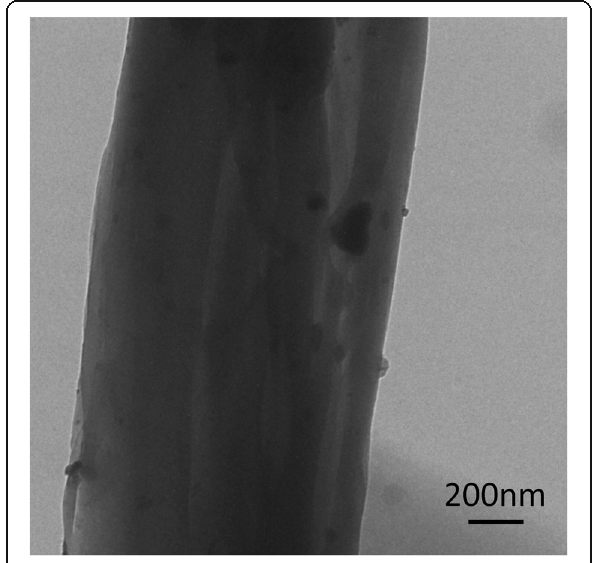
Fig. 4 TEM images of γ -Fe 2 O 3 /PU composite fiber membranes prepared with the use of an auxiliary